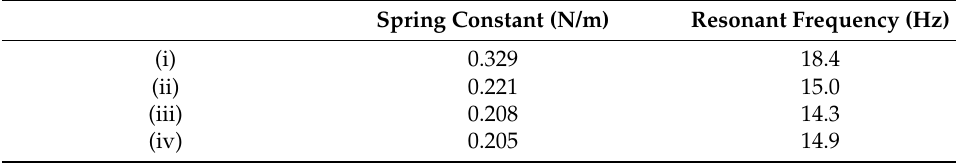
Table 2. Experimental characteristics of the fabricated force